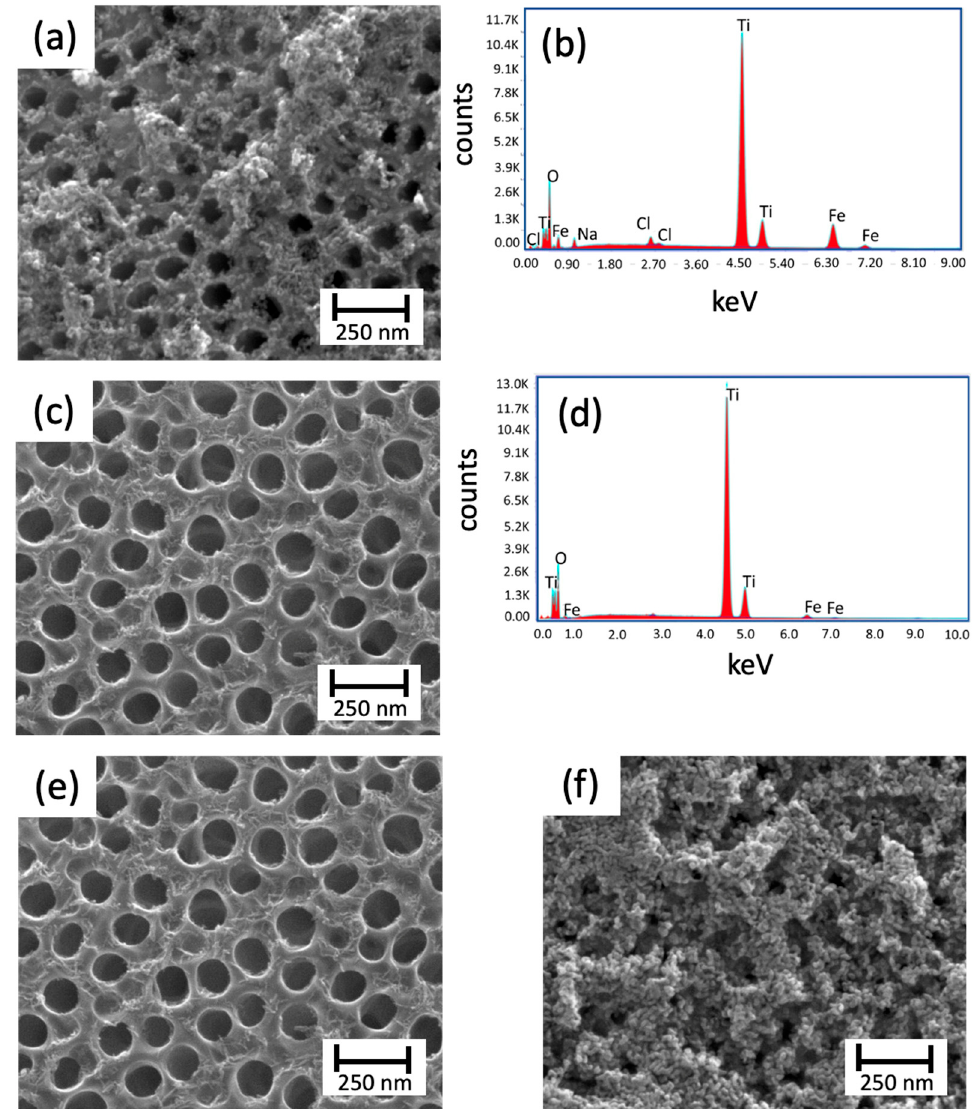
Figure 5. Top view SEM micrographs and EDS measurements of the TiO 2 nanotubes modified with hematite through SILAR; ( a , b ) nt-TiO 2 / α -Fe 2 O 3 (H 2 O); ( c , d ) nt-TiO 2 / α -Fe 2 O 3 (MetOH) using 10 and 50 cycles, respectively; ( e ) nt-TiO 2 / α -Fe 2 O 3 (Cl − ); and ( f ) nt-TiO 2 / α -Fe 2 O 3 (NO (cid:2871)(cid:2879) ) .